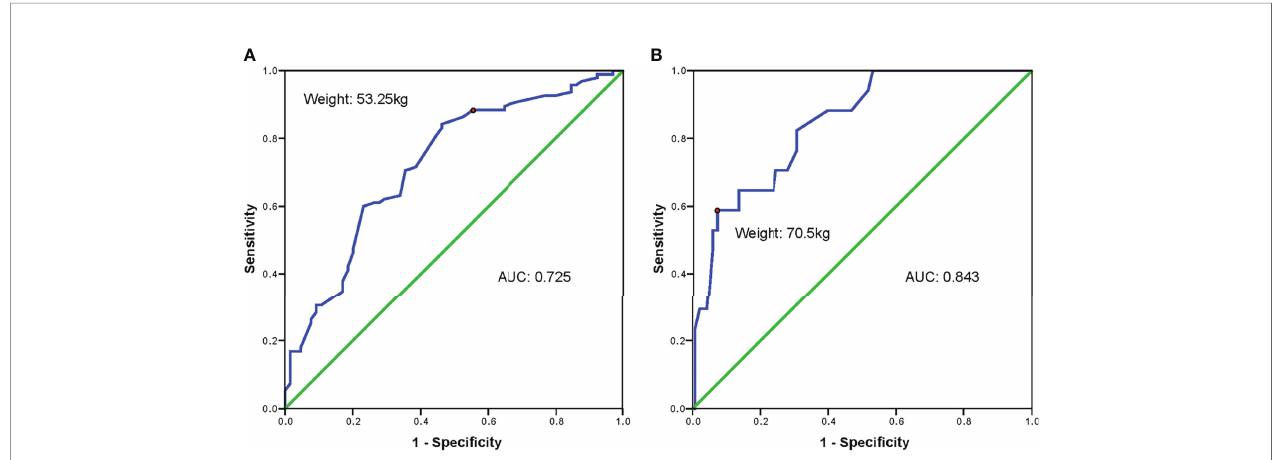
Figure 1 Receiver operating characteristic curves of body weight in predicting initial Gn dosage set up in PCOS patients with normal ovarian response. (A) body weight in predicting initial Gn dosage higher than 150 IU/day in PCOS patients with normal ovarian response; (B) body weight in predicting initial Gn dosage higher than 225 IU/day in PCOS patients with normal ovarian response. AUC, area under curve.